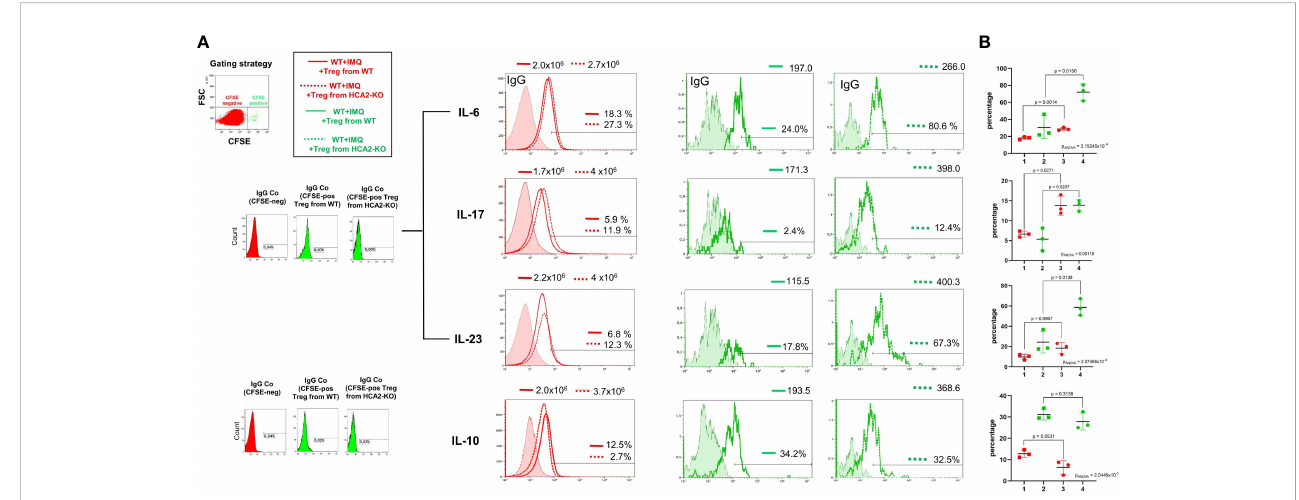
FIGURE 4 HCA2 de fi ciency causes defects of Treg at the site of in fl ammation. (A) Treg obtained from 7 HCA2-KO and 7 WT mice were stained with CFSE and injected i.v. into IMQ-treated WT animals. After 48 h LN and spleens were obtained from the recipient mice and FACS analysis of CFSE-negative (overlay of red histograms) or CFSE-positive cells (overlay of green histograms) was conducted. The expression of IL-6, IL-17, IL-23 and IL-10 was standardized on isotype controls. For green histograms (Treg from WT and HCA2-KO) two isotype controls were used. For IL-6, IL-17 and IL-23 the same IgG (rat IgG1) control was used. Histograms show fl uorescence intensity (x axis) versus cell count (y-axis). The number of cells is displayed in the histograms. (B) FACS analysis is also shown as scatter graph with mean ± SD. Y axes show percentage of positive cells. Data were analyzed by using the t test with Welch´s correction. For multiple comparisons we carried out one-way ANOVA in order to assess whether at least two groups signi fi cantly differ. 1 WT +IMQ + Treg from WT (red); 2 WT +IMQ + Treg from WT (green); 3 WT +IMQ + Treg from HCA2-KO (red); 4 WT +IMQ + Treg from HCA2-KO (green)